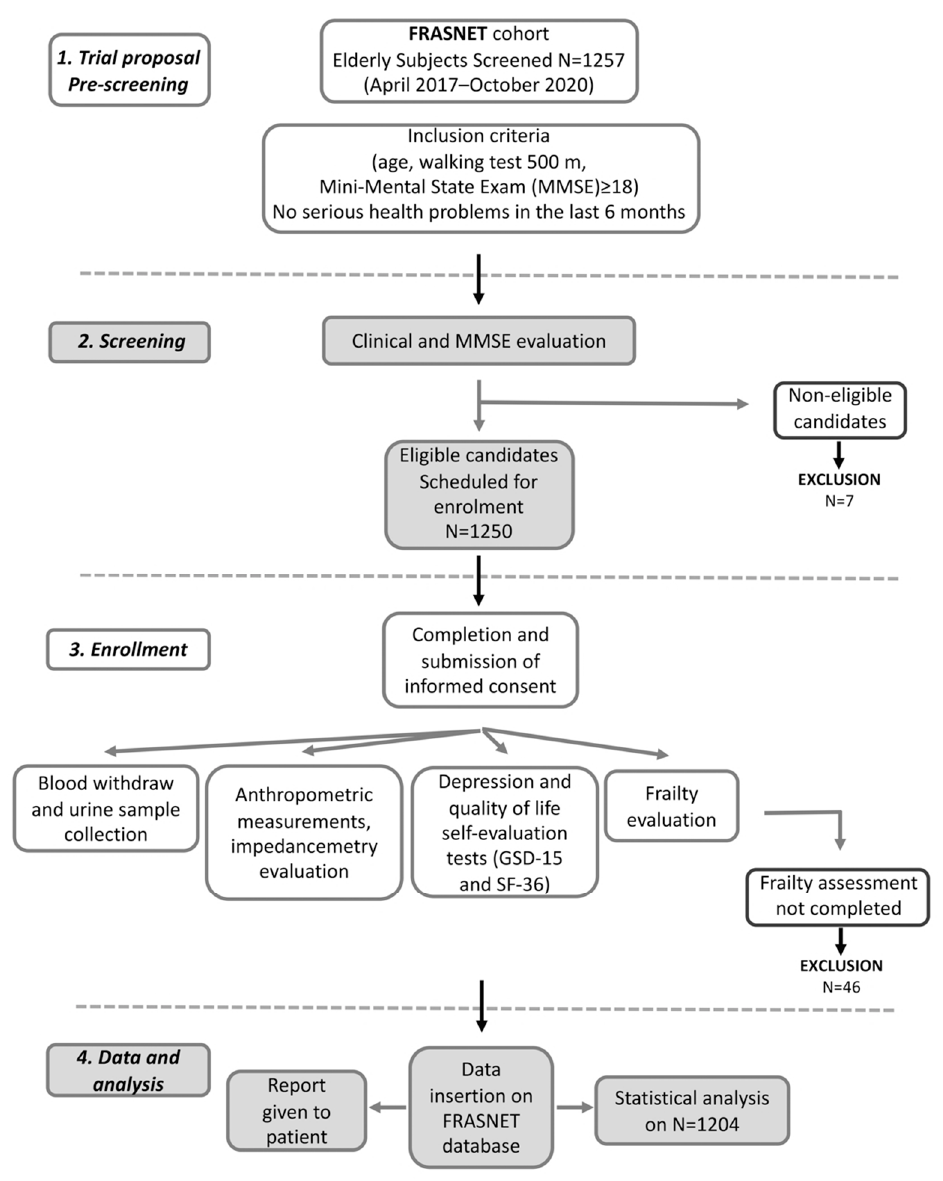
Figure 1. Flow chart for frailty analysis in FRASNET study.